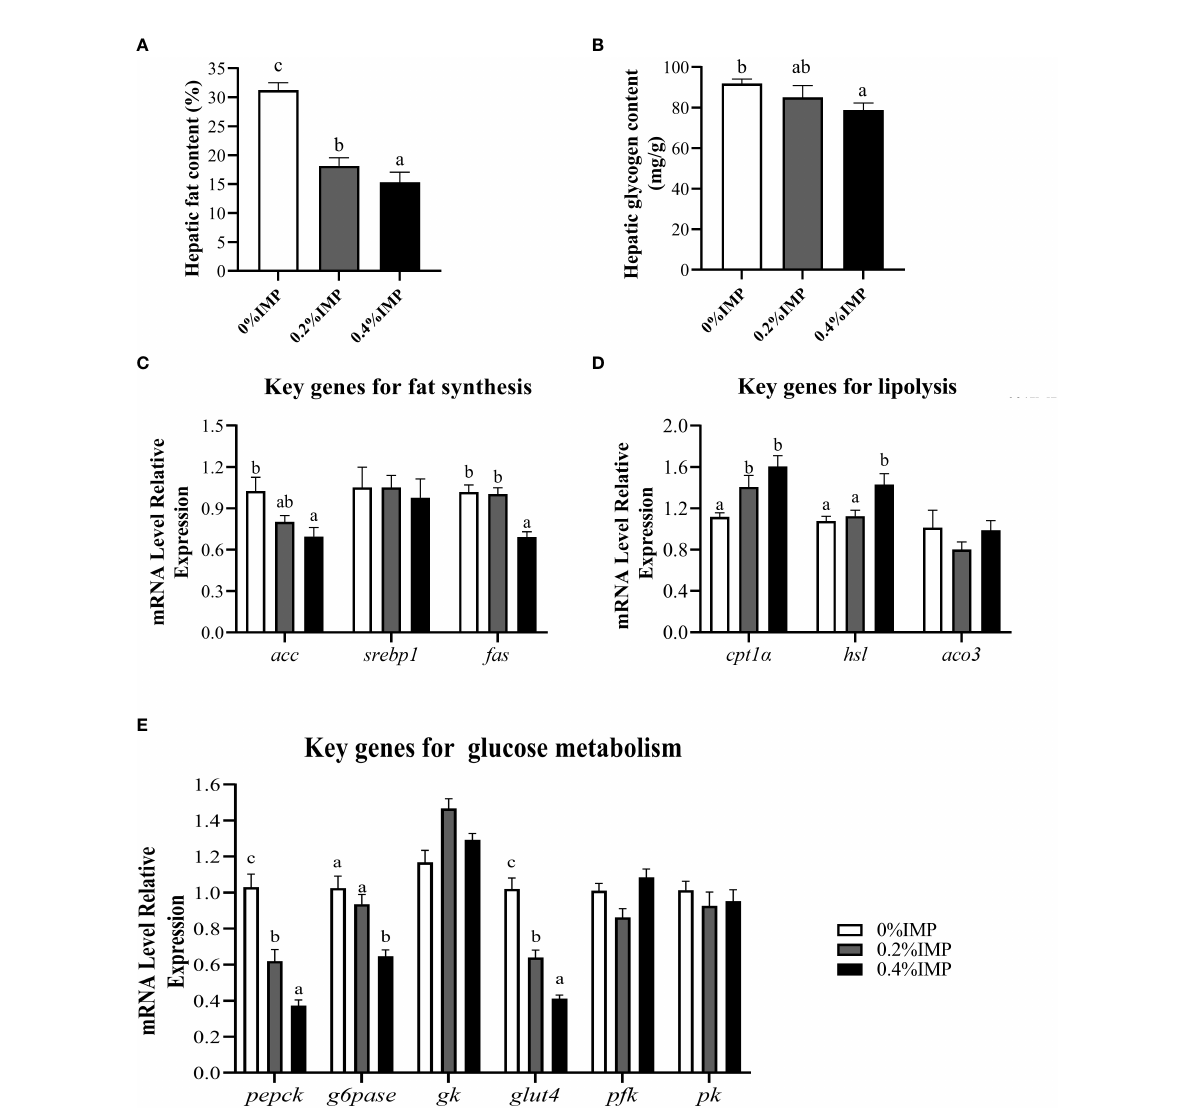
FIGURE 2 Effect of IMP supplementation on hepatic glycolipid metabolism of gibel carp. (A) The fat content in liver (B) The glycogen content in liver. (C) The expression of fat synthesis genes in liver ( acc, srebp1 and fas ). (D) The expression of lipolysis genes in liver ( cpt1 a , hsl, aco3 ). (E) The expression of glycometabolism genes in liver ( pepck, g6pase, gk, glut4, pfk, pk ). Columns represent the mean ± SEM (n=6). For each index, bars without sharing a common letter indicate signi fi cant differences ( P